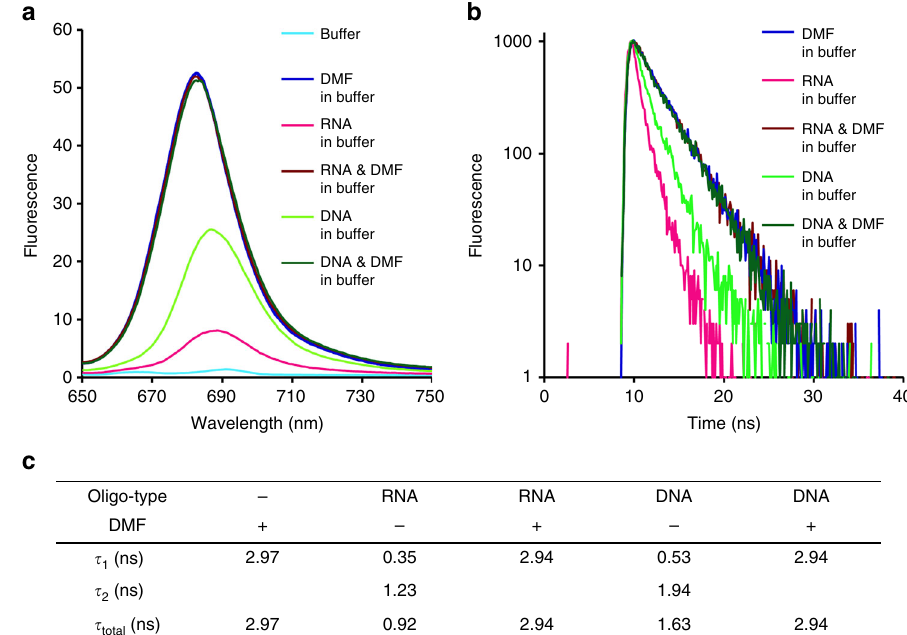
Fig. 6 Energy transfer from ZnAPC to NRAS RNA is greater than that to NRAS DNA. a Fluorescence spectra of 2 μ M ZnAPC under the following experimental conditions: in the absence of NRAS RNA in the buffer (right blue) and in the buffer containing 30 wt% DMF (dark blue), in the presence of NRAS RNA in the buffer (red) and in a buffer containing 30 wt% DMF (brown), in the presence of NRAS DNA in the buffer (light green), and in the buffer containing 30 wt% DMF (dark green). b Fluorescence decay of ZnAPC under the experimental conditions listed in a . Fluorescence decay in the buffer is not shown because of the insuf fi cient fl uorescence intensity. All the experiments were conducted with 2 µ M ZnAPC, 10 µ M NRAS RNA, and 10 µ M NRAS DNA. c Fluorescence lifetime, τ , was evaluated with a theoretical equation of single or double exponential decay for the fl uorescence decay obtained in